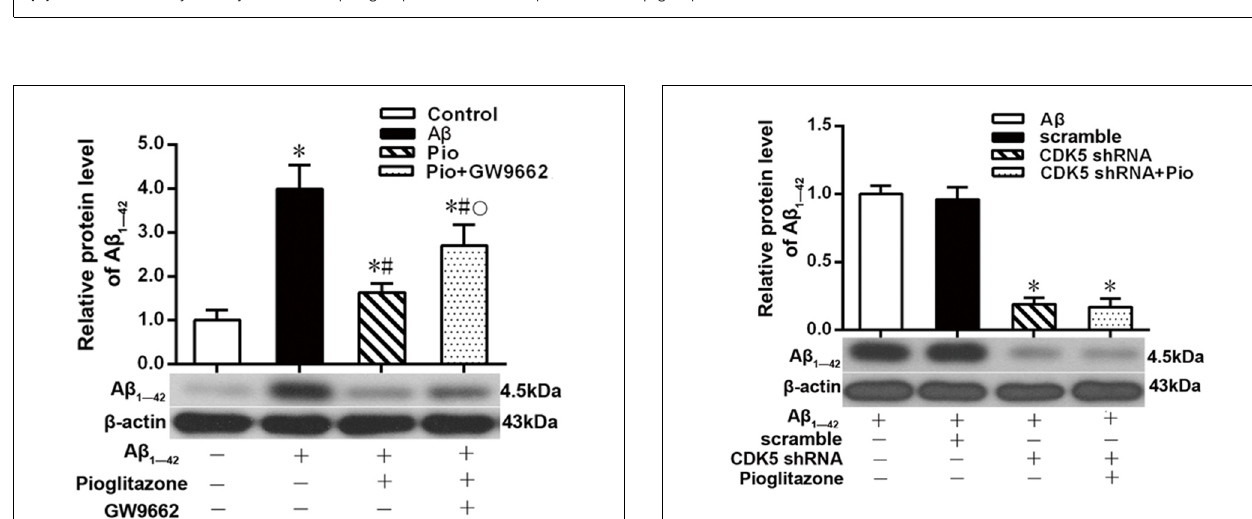
FIGURE 2 | Effects of pioglitazone on A β 1–42 induced apoptosis in rat hippocampal neurons after cyclin-dependent kinase 5 (CDK5) silencing. (A) Results of TUNEL staining. Green represents nuclei with positive TUNEL staining (indicated by red arrows), and blue represents nuclei counterstained with DAPI. Scale bar, 50 µ m. (B) Results of flow cytometry. n = 6 wells per group. ∗ P < 0.05 compared to the A β group.